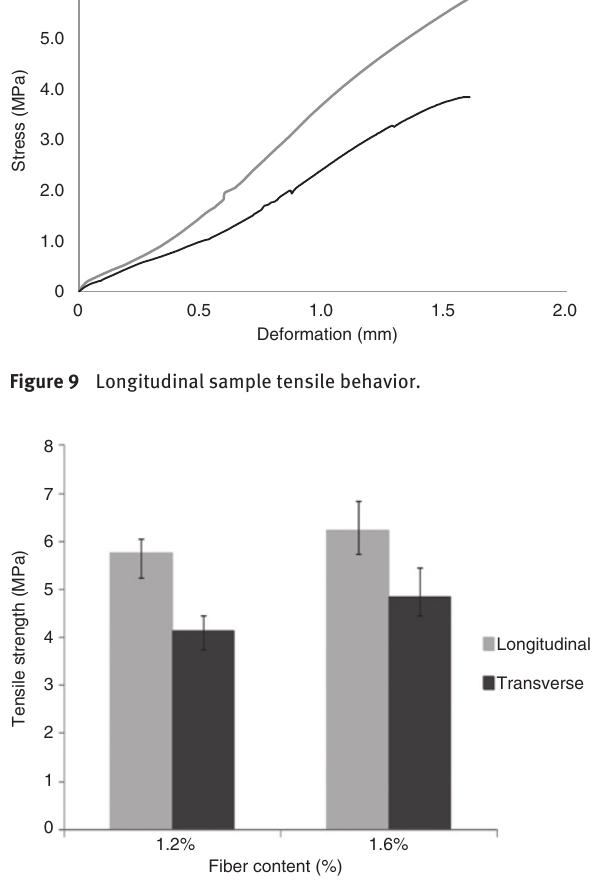
Figure 10 Tensile strength.